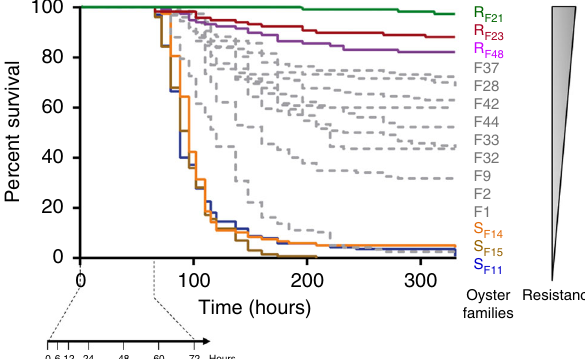
Fig. 1 Production of oyster biparental families with contrasted resistance phenotypes. Kaplan – Meier survival curves of the 15 families of recipient oysters ( n = 1000 for each family) during the ‘ natural ’ experimental infection. At each time indicated on the arrow, 3 triplicates of 10 oysters were sampled from each tank for further molecular